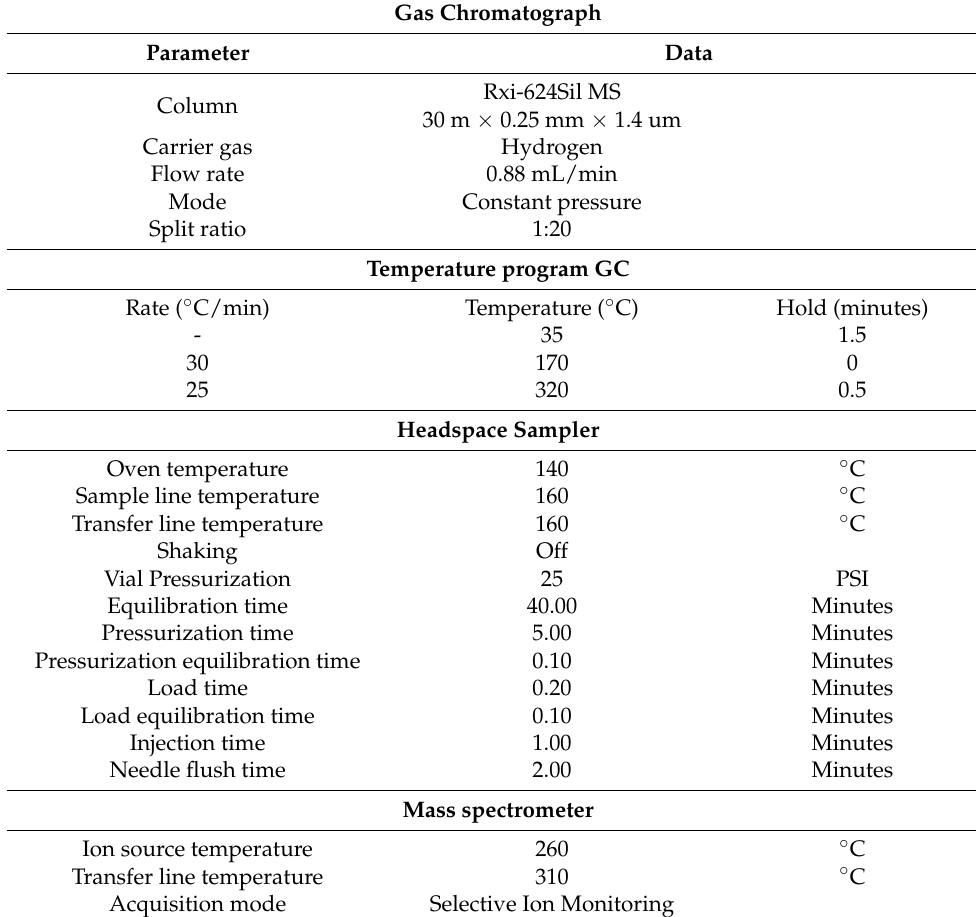
Table 1. Method parameters for the HS-GC/MS/MS